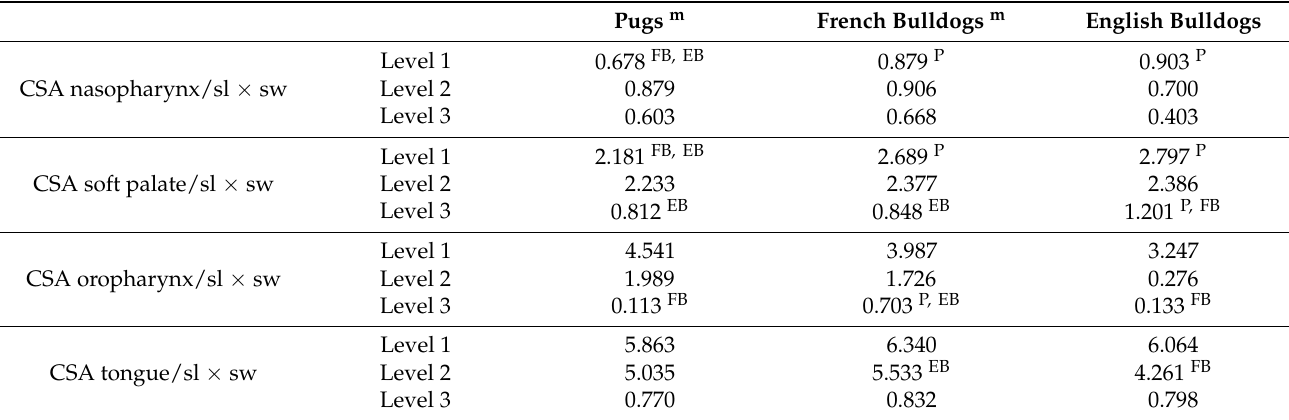
Table 3. Cross sectional areas of the nasopharynx, soft palate, oropharynx, and tongue normalized to skull length × skull width.